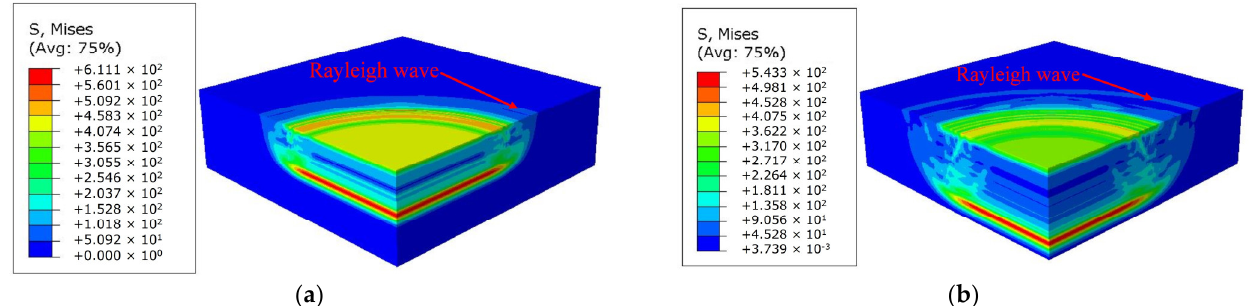
Figure 8. Nephograms of surface Rayleigh wave propagation in sample at ( a ) 130 ns and ( b ) 220 ns.